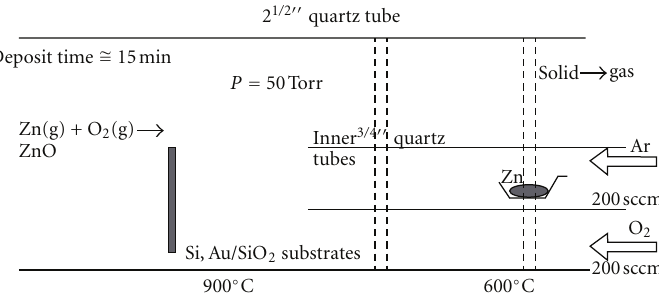
Figure 1: Experimental setup to grow ZnO by physical vapor deposition in a horizontal quartz tube reactor.